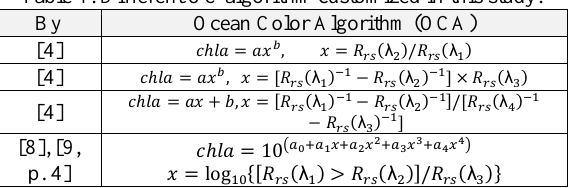
Table 1. Table 1. Different OC algorithm customized in this study.